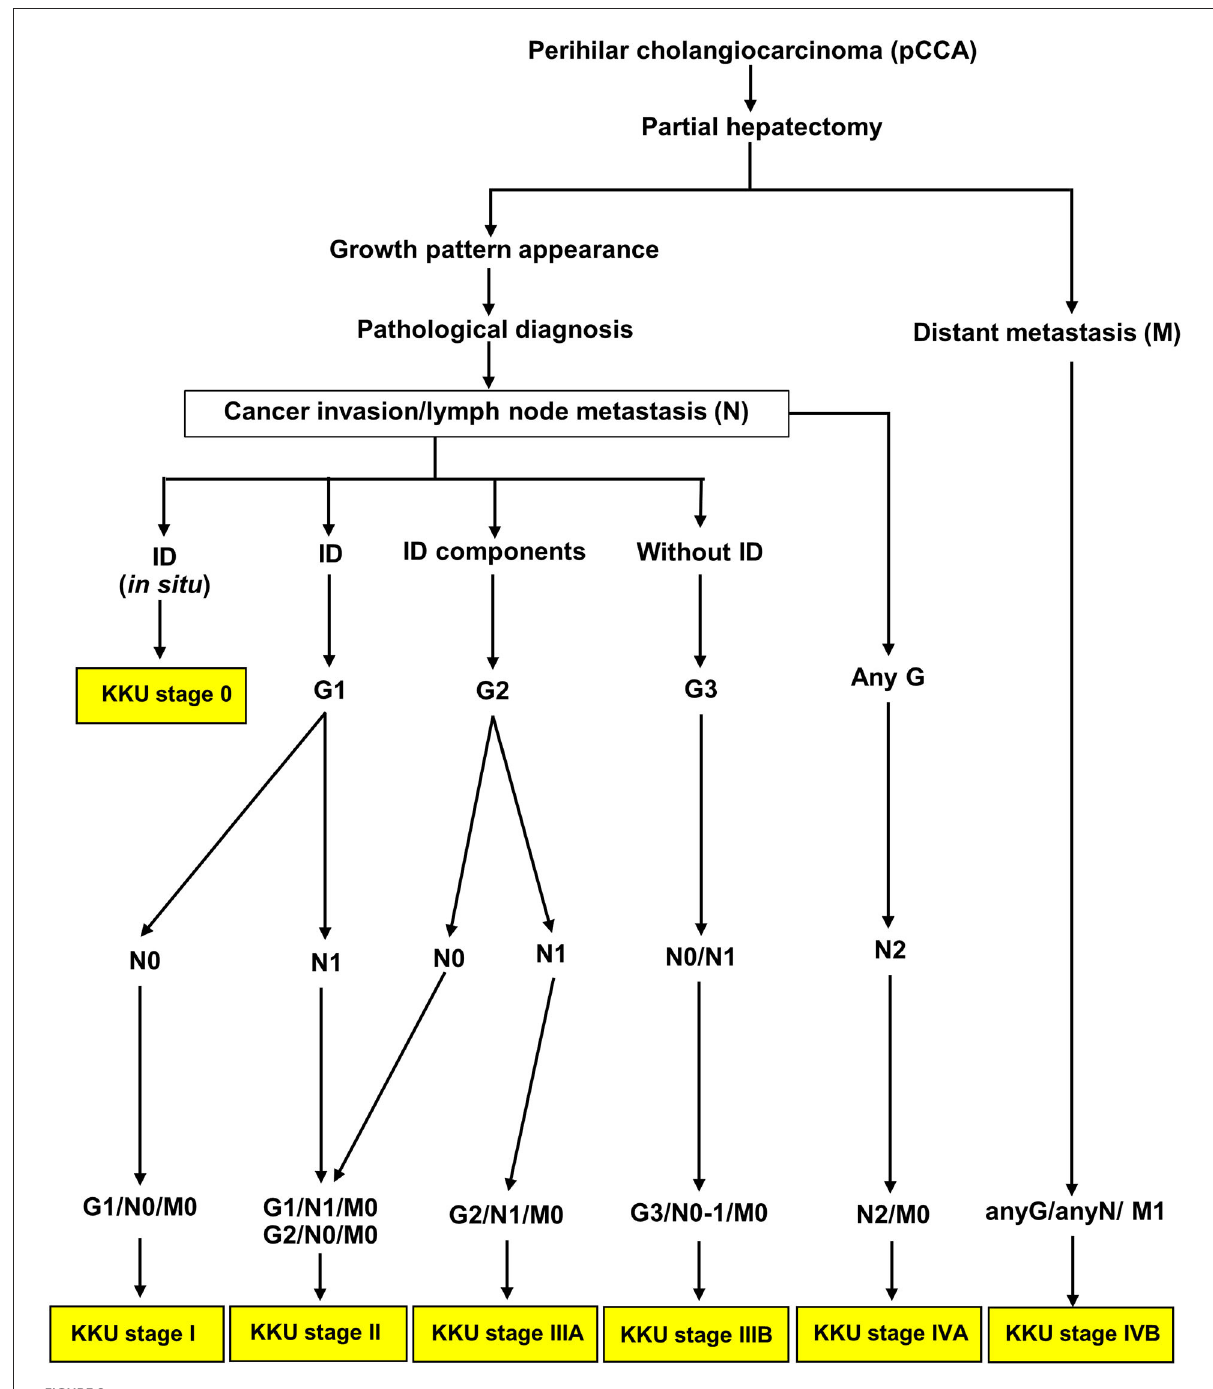
FIGURE8 Schematic of the KKU staging system for classifying patients with perihilar